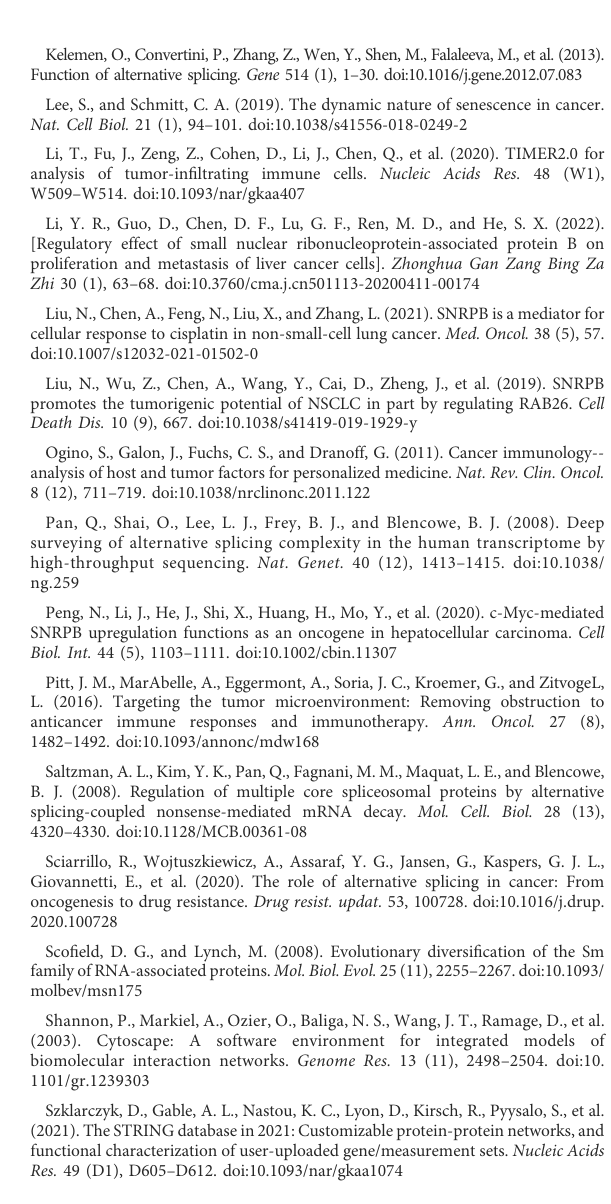
SUPPLEMENTARY FIGURE 2 Relationship of SNRPB with the expression of immunomodulation- related genes across tumors. (A) The relationship of SNRPB and the expression of immune activation-related genes across tumors. (B) The relationshipofSNRPBandtheexpressionofimmunosuppression-related genes across tumors. SUPPLEMENTARY FIGURE 3 Relationship of SNRPB with the expression of immunomodulation- related genes across tumors. (A) The relationship of SNRPB and the expression of chemokine genes across tumors. (B) The relationship of SNRPB and the expression of chemokine receptor genes across